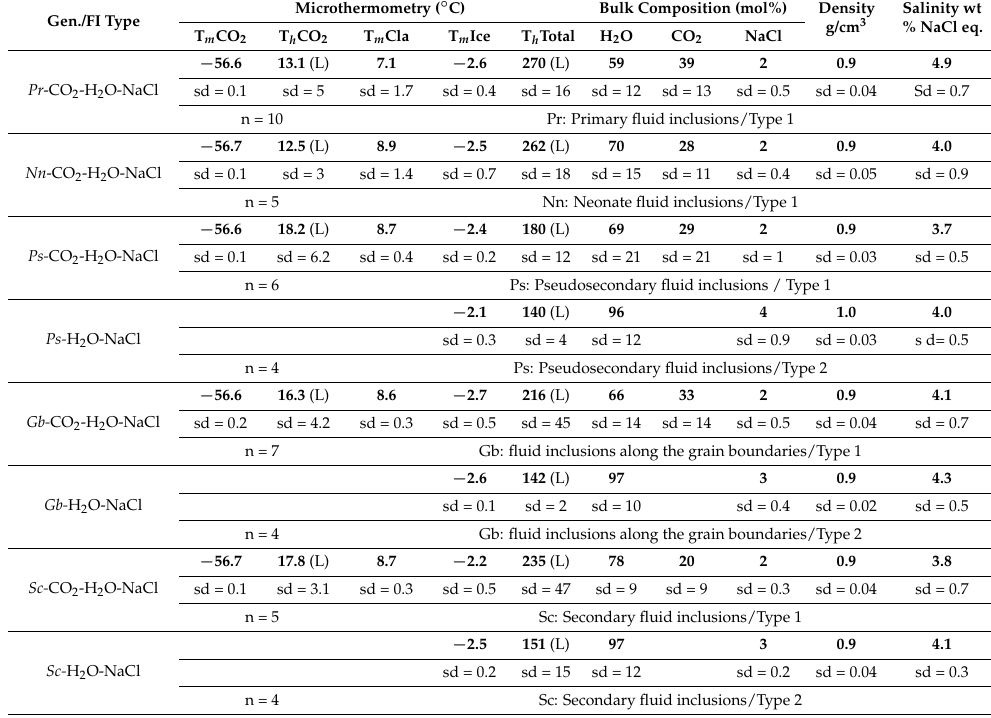
Table 2. Microthermometric data, calculated bulk composition and salinity for selected fluid inclusion